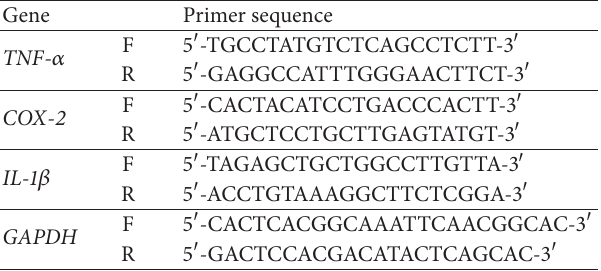
Table 1: Sequences of primers used in real-time PCR analysis. Gene